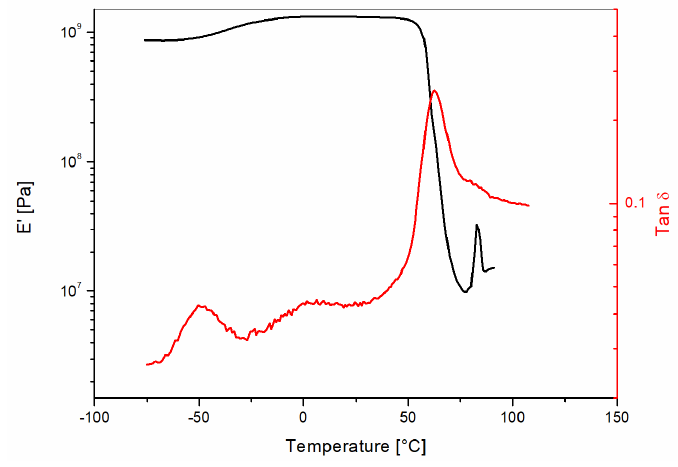
Figure 3. Dynamic mechanical analysis of the as ‐ received Liquid Wood sample.